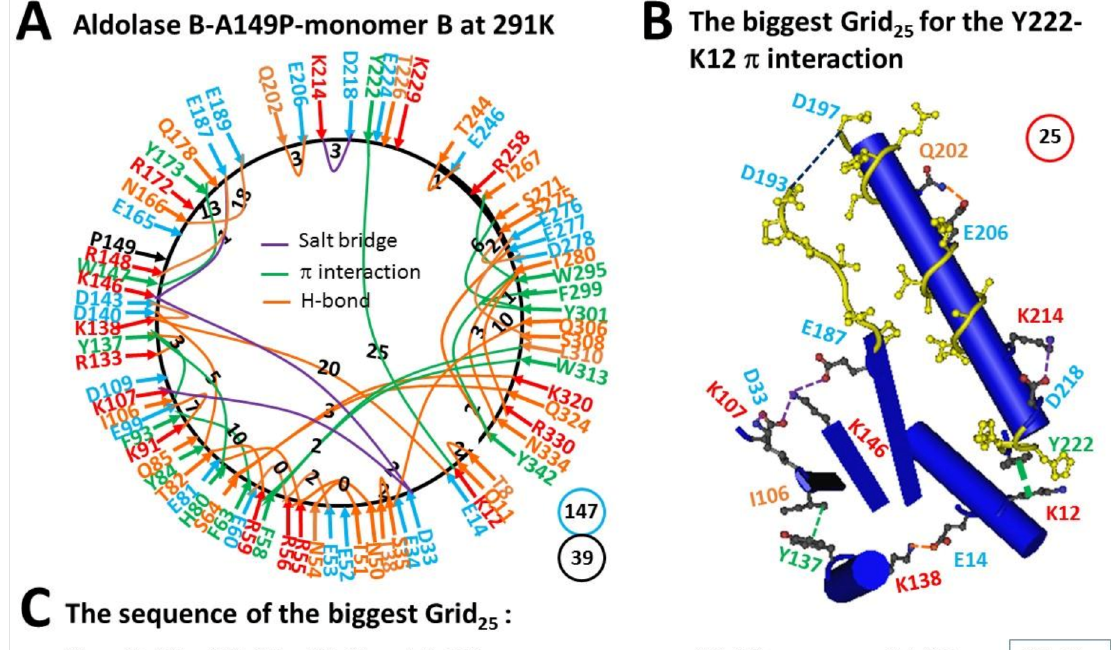
Figure 2. The grid-like non-covalently interacting mesh network along the single polypeptide chain of ligand-free monomer B in the aldolase B-A149P tetramer at 291 K. ( A ) The topological grids in the systemic fluidic grid-like mesh network. The X-ray crystallographic structure of monomer A in aldolase B-A149P at 291 K (PDB ID, 1XDM) was used for the model [2]. Salt bridges, π interactions, and H-bonds between pairing amino acid side chains along the single polypeptide chain from T8 to Y342 are marked in purple, green, and orange, respectively. The grid sizes required to control the relevant non-covalent interactions were calculated with graph theory and labeled in black. The total grid sizes and grid size-controlled non-covalent interactions along the single polypeptide chain are shown in the blue and black circles, respectively. ( B ) The structure of the biggest Grid 25 . The grid size is shown in a red circle. ( C ) The sequence of the biggest Grid 25 to control the Y222-K12 CH- π interaction in a blue